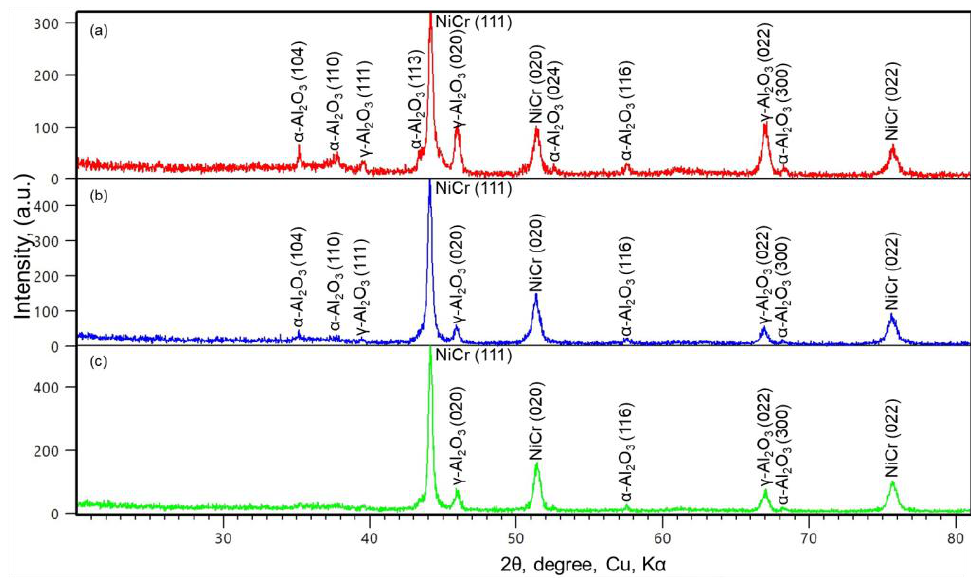
Figure 5. Load – displacement curves of the surface of multilayer gradient coatings: (a) three-layer; (b) five-layer and (c) six-layer. Figure 4 shows micrographs of the surface and measured results of the multilayer gradient coatings ’ roughness obtained by detonation spraying. Using the method of roughness determination and metal microscopy, it was found that all the studied samples were characterised by fine-grained surface topography. The highest surface roughness was shown by the six-layer coatings ( R a = 19.2 µm), and minor roughness was exhibited by the gradient structures ( R a = 15.3 µm). Figure 6 shows the cross-section microstructure with an EDS mapping colour image and analysis result of a three-layer coating obtained by successive spraying of powders from the lower metal layer (NiCr) of the upper ceramic layer (Al 2 O 3 ) and the transition layer from a mechanical mixture of metal and ceramics (50% NiCr 50% Al 2 O 3 ). It can be seen from the figure that the coating was a multilayer system that consisted of a ceramic outer coating (top layer) and a metal inner coating (binder layer) between the ceramic and the substrate.